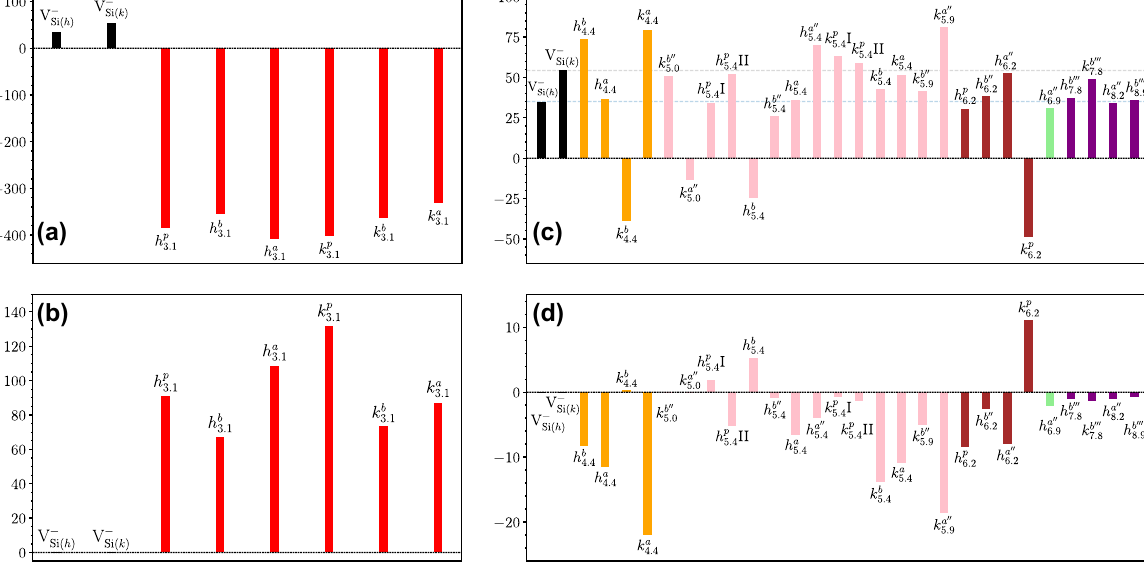
Figure 5: ZFS for the modified silicon vacancies (HSE results). (a) The D value and (b) the E value for the six closest configurations of the modified silicon vacancies compared with the isolated silicon vacancy; (c) the D-tensor and (d) the E-tensor for the remaining configurations. The data is grouped by distinct colors to easily identify the carbon antisite distance from the silicon